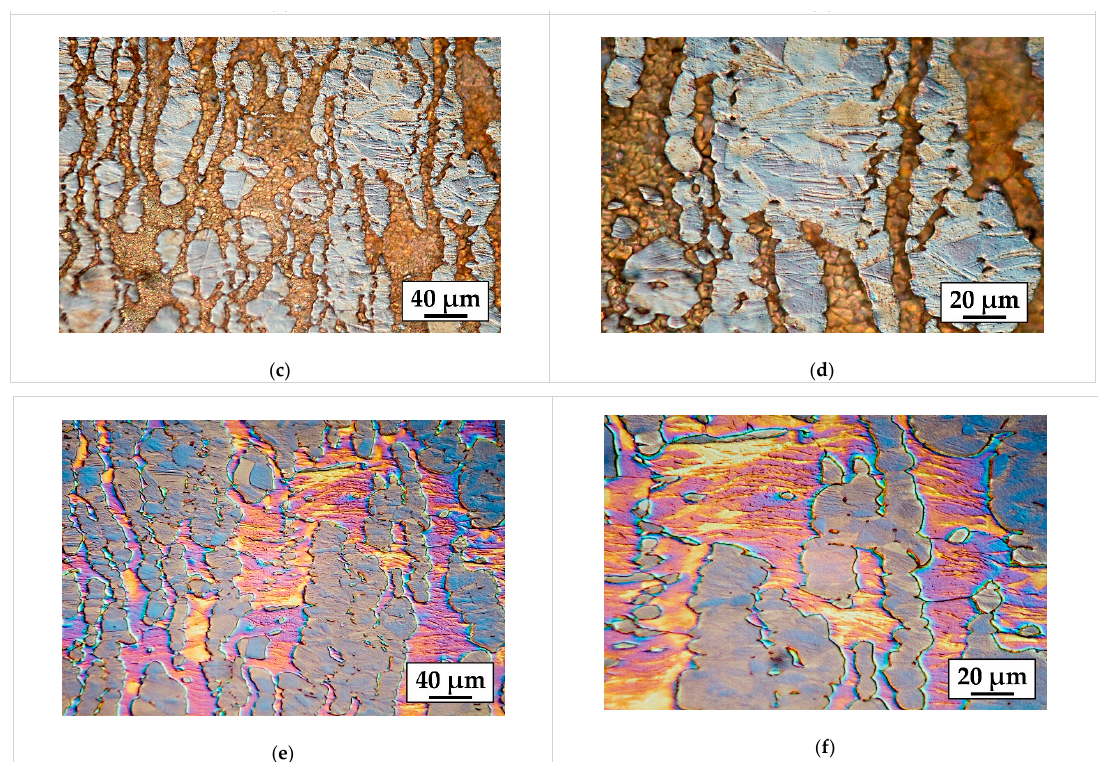
Figure 6. Deformation bands inside austenite and ferrite due to thickness reduction. ( a ) 29.6% thickness reduction, ( b ) 39.9% thickness reduction, ( c , d ) 49.9% thickness reduction, and ( e , f ) 60.3% thickness